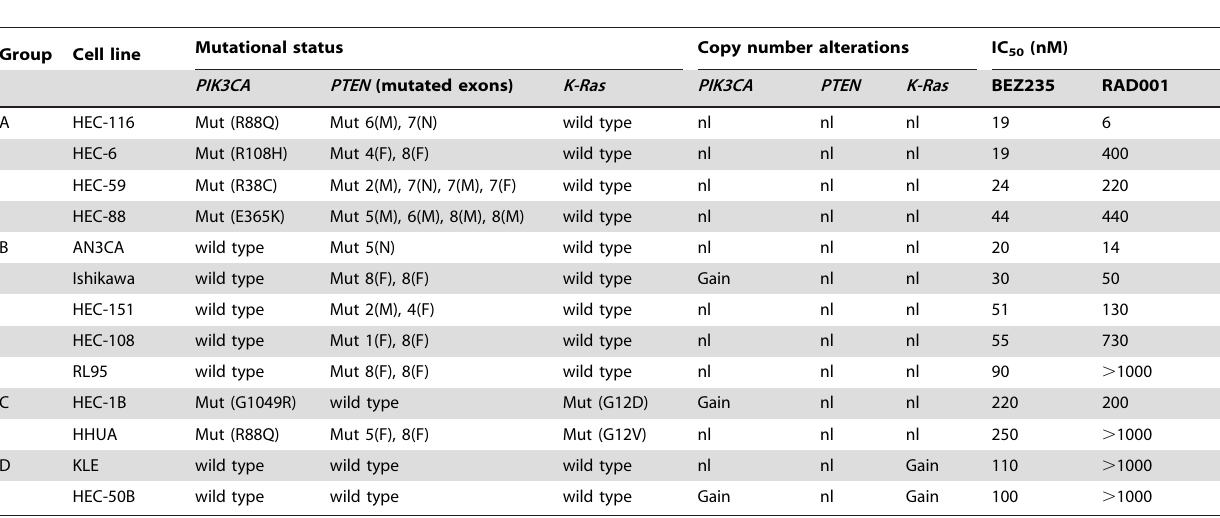
Table 1. Classification of endometrial cancer cell lines by mutational status and IC50 values to NVP-BEZ235 and RAD001.